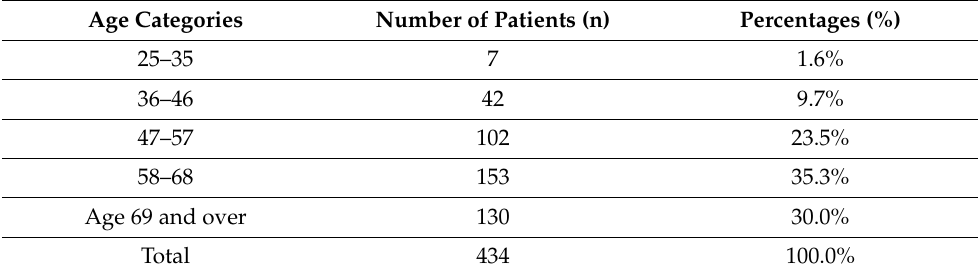
Table 2. Distribution of DFI patients by age.